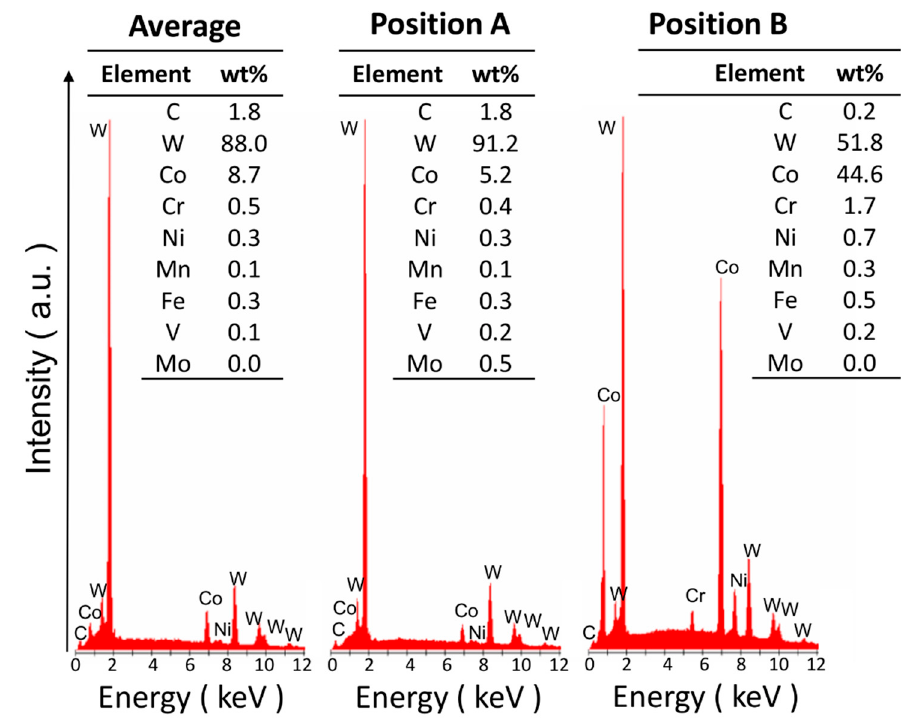
Figure 4. Comparison of the EDS spectra and semi-quantitative analysis for the various positions indicated in Figure 1. The analysis was repeated three times in each position and the results are listed here in terms of average weight percentages.